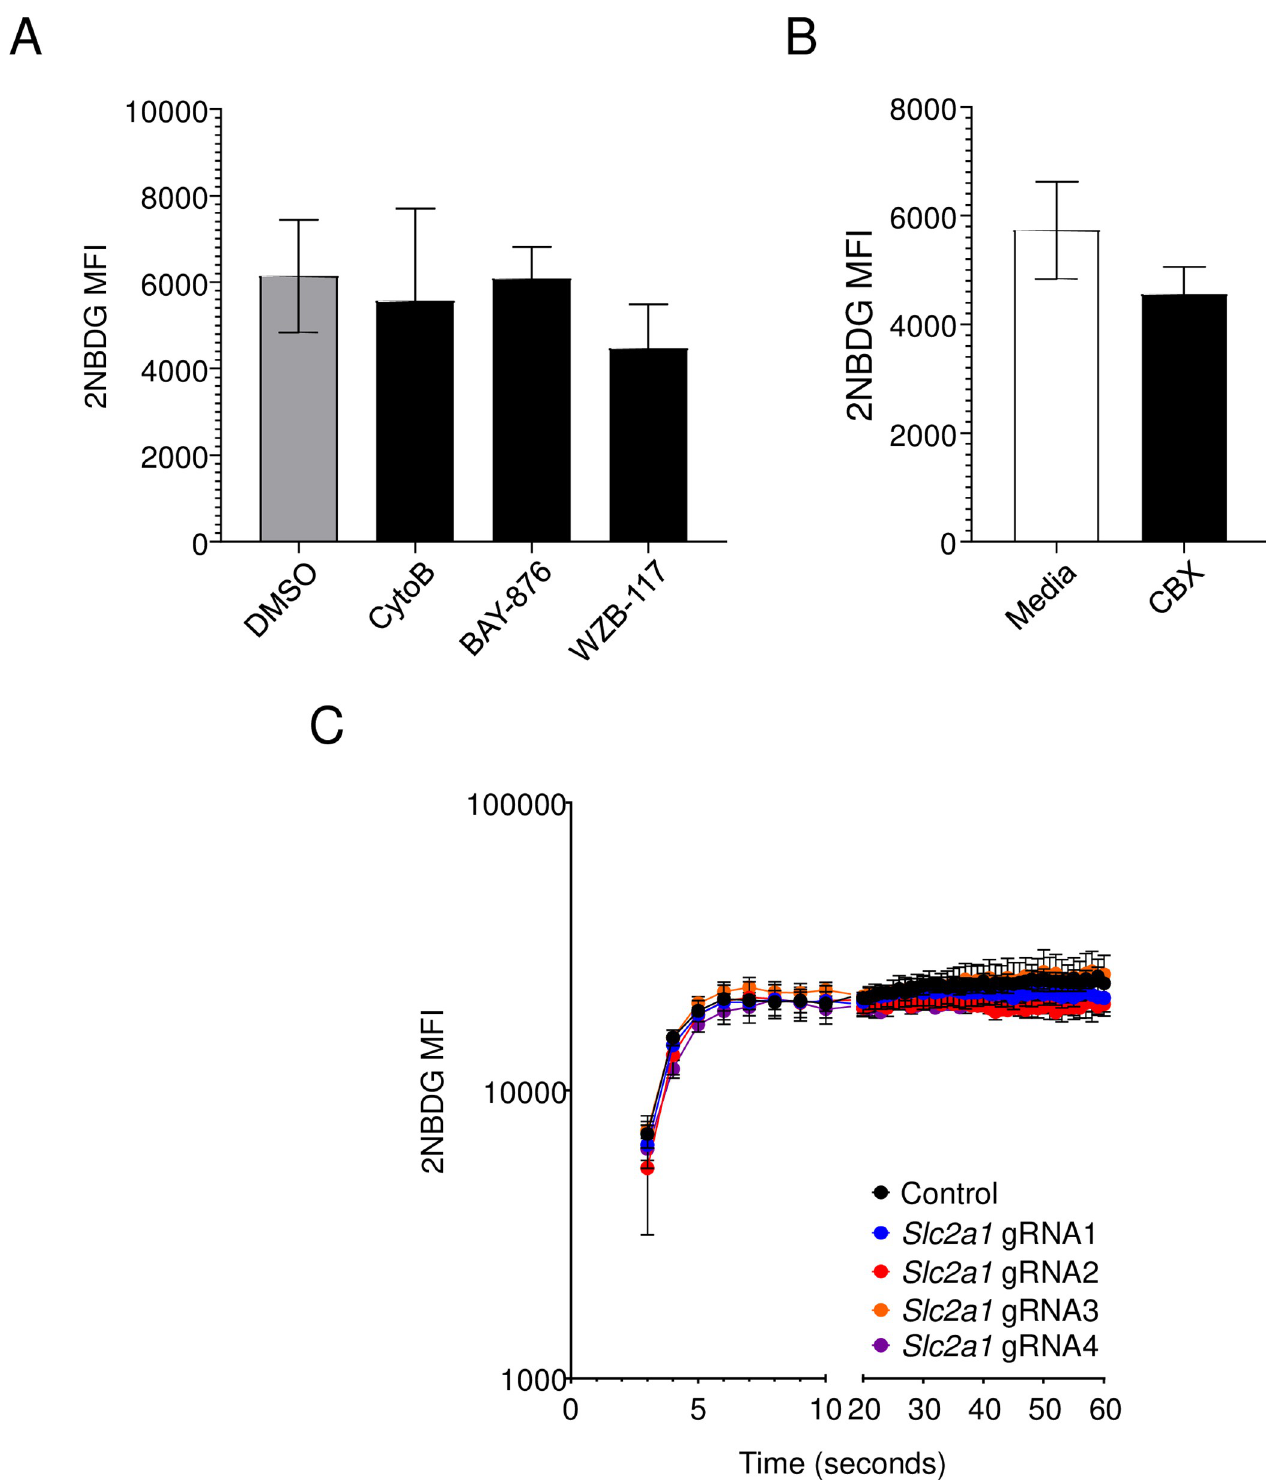
Fig 4. The kinetics of 2NBDG uptake is unaffected by GLUT1 inhibition or deletion. (A) 5TGM1 cells were treated with DMSO, 30 μ M Cytochalasin B (CytoB), 10 μ M BAY-876, or 100 μ M WZB-117 for 30 minutes in complete media followed by 60 μ M of 2NBDG for another 30 minutes. Mean +/- SEM of 2NBDG MFI are shown as bar graphs. Pooled data from three independent experiments. No significance was observed by one-way ANOVA. (B) 5TGM1 cells were treated with 300nM Carbenoxolone (CBX) and assayed for 2NBDG uptake as in (A). Mean +/- SEM of 2NBDG MFI are shown as bar graphs. Pooled